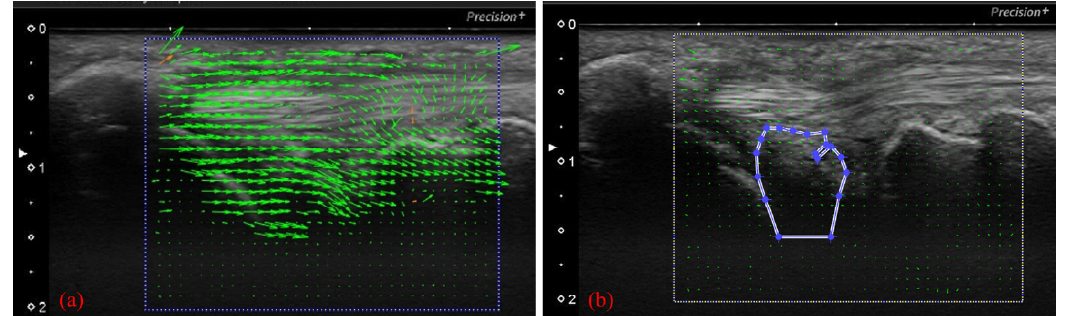
Figure 5. ( a ) Analyzing velocity magnitude image by using particle image velocimetry (PIV) fluid measurement software. With the US images, setting the articular disc and ECU tendon as regions of interest of the PIV. ( b ) Specification of the area to be measured (articular disc).